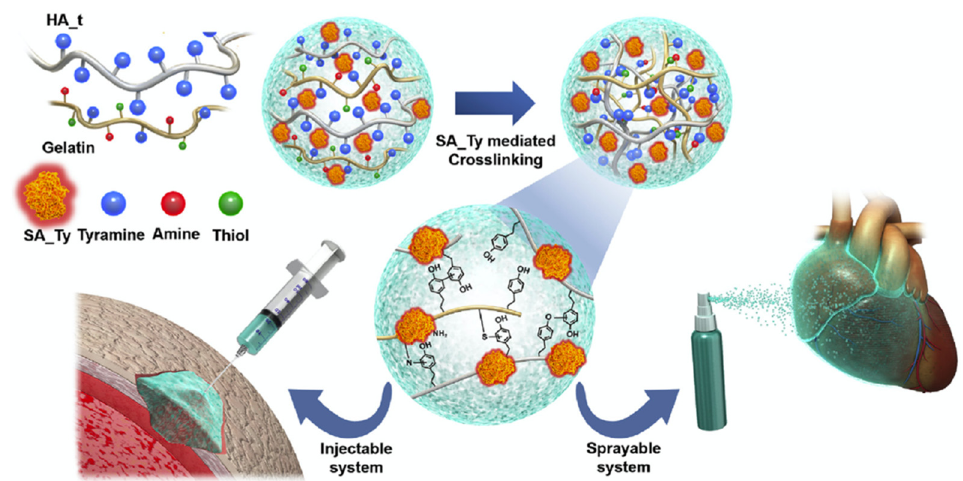
Figure 5. Visualization of the development of an HA-based, injectable and sprayable formula to be applied in tissue engineering as a post-surgical tissue adhesive and encouragement for cellular recruitment to damaged tissue. Reprinted with permission from ref. [18]. 2018 Elsevier.